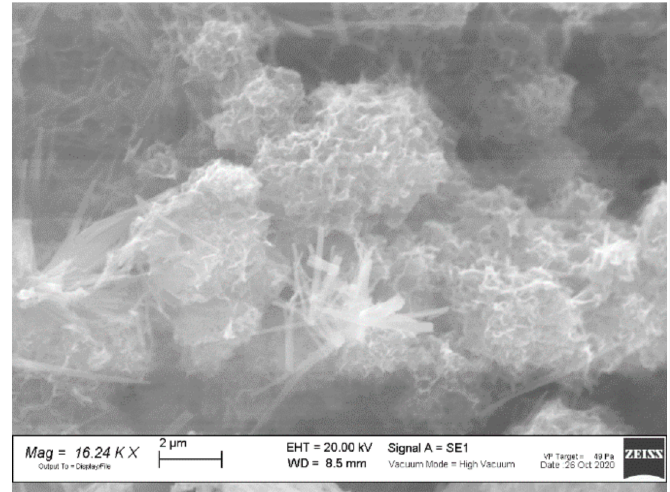
Figure 11. SEM image of the Zn 3 (BTC) 2 sample after OFL adsorption in tap